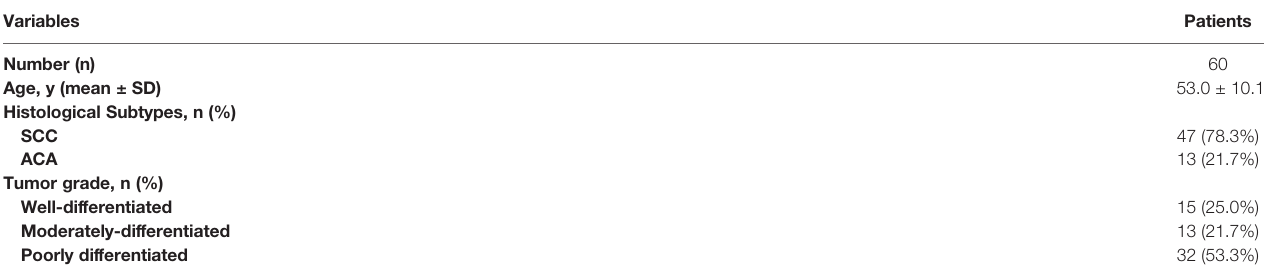
TABLE 2 | Summary of the demographic and clinical features of the patients.